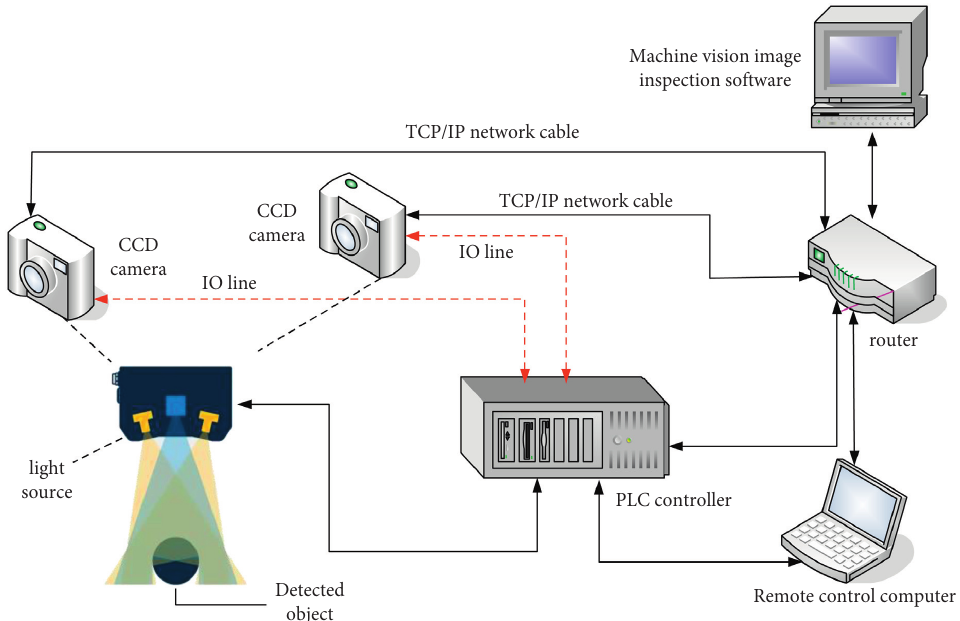
Figure 1: Machine vision system block diagram.